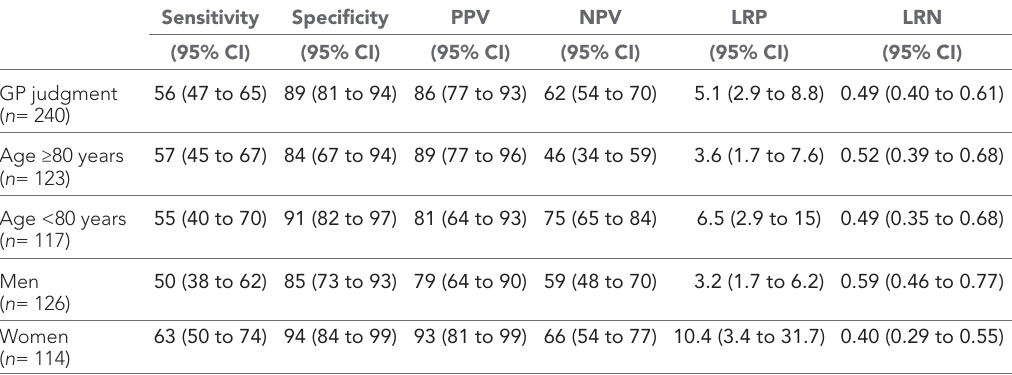
Table 2 Accuracy of GP judgment for the diagnosis of dementia Sensitivity